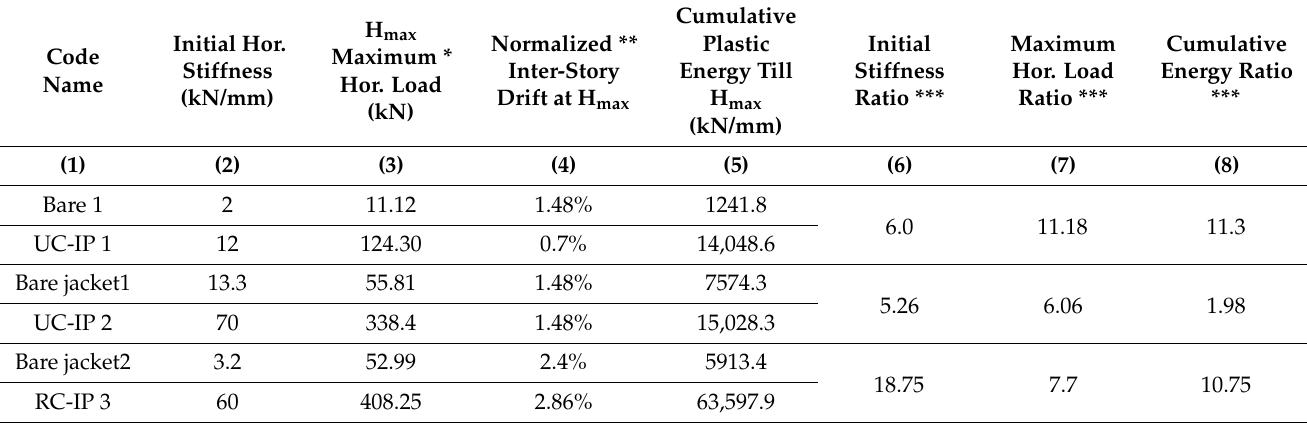
Table 3. Summary of the obtained peak response of the Bare and the Infilled